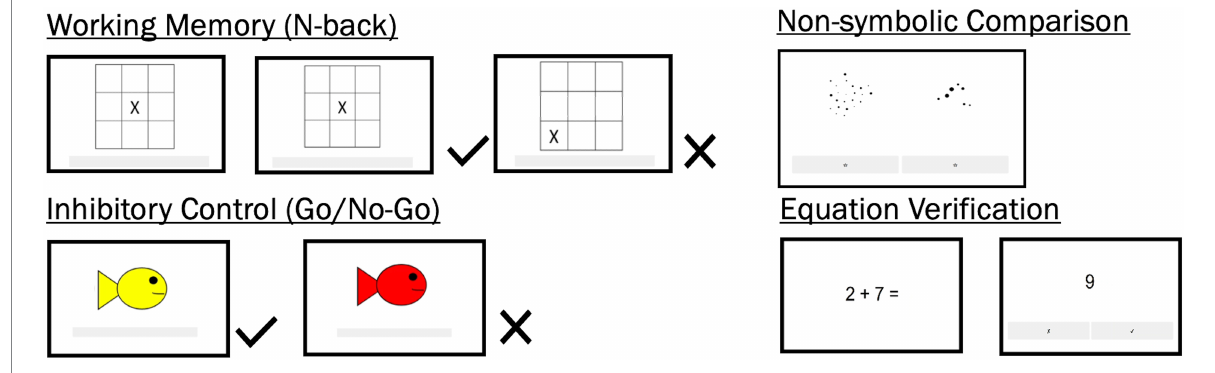
FIGURE 2 Cognitive Tasks. Participants completed four cognitive tasks. See Methods section for the tasks’